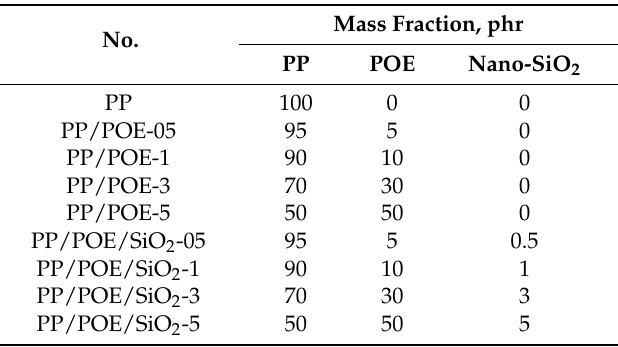
Table 1. Abbreviation and component of